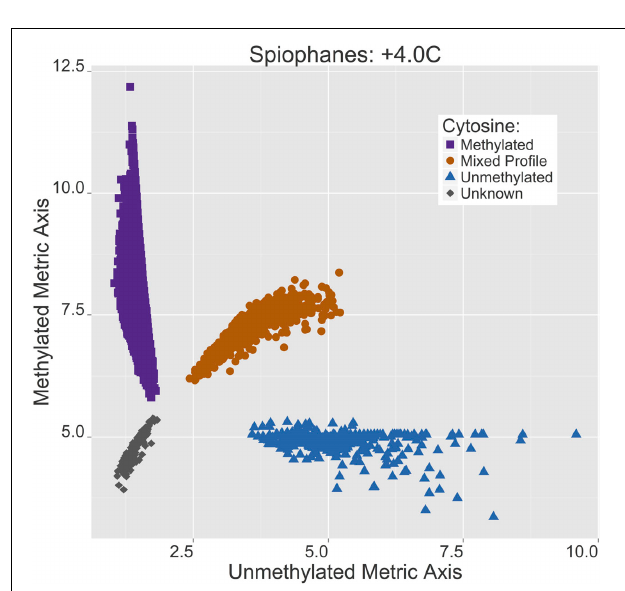
FIGURE 4 | Spiophanes tcherniai methylation score profile for the + 4 ◦ C worms. Each point represents a single CpG site that has been scored for a proportional representation of methylated and non-methylated copies in these samples, with these two variables plotted on each axis. Points are divided into four groups: purple squares = methylated sites, brown circles = mixed methylation sites, blue triangles = unmethylated sites, gray diamonds = unknown or unresolved